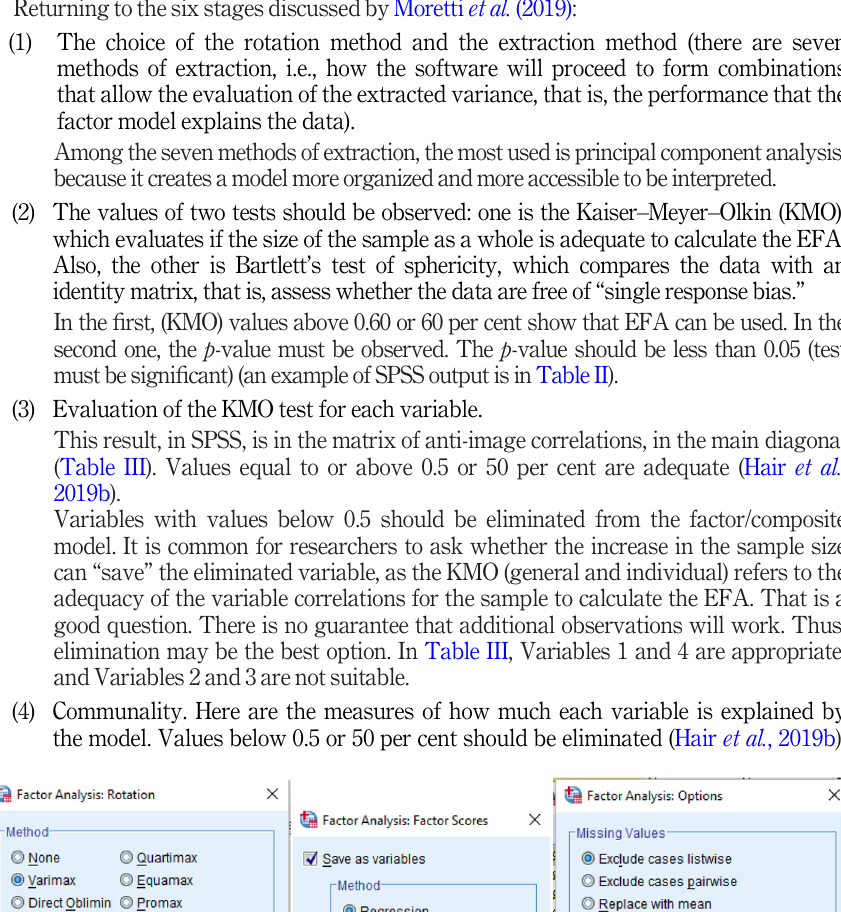
Figure 4. Dialog boxes of rotation, factor scores and options in SPSSS software